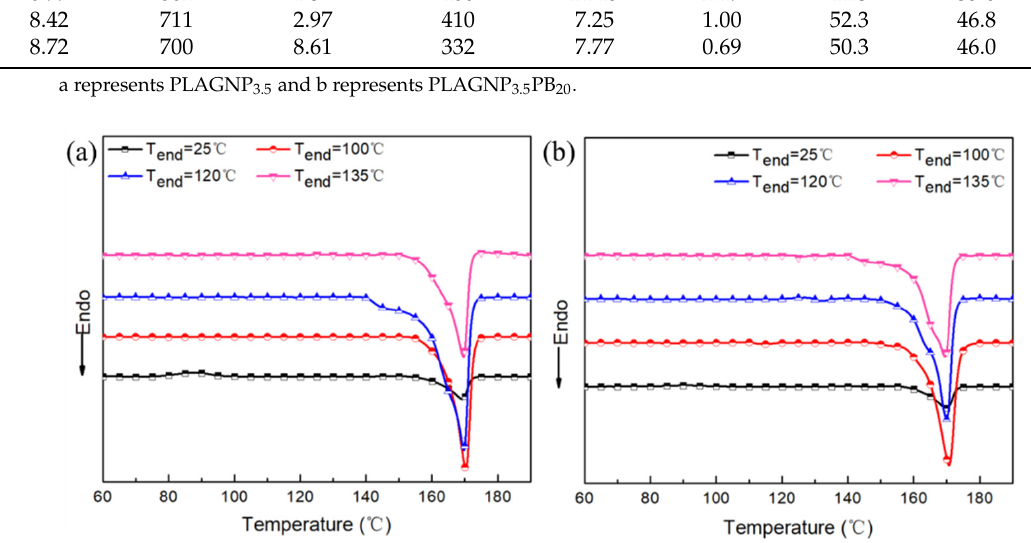
Figure 6. ( a ) The heating DSC curve of PLAGNP 3 . 5 composite and ( b ) DSC curve of PLAGNP 3 . 5 PB 20 composite at different heat treatment temperatures.